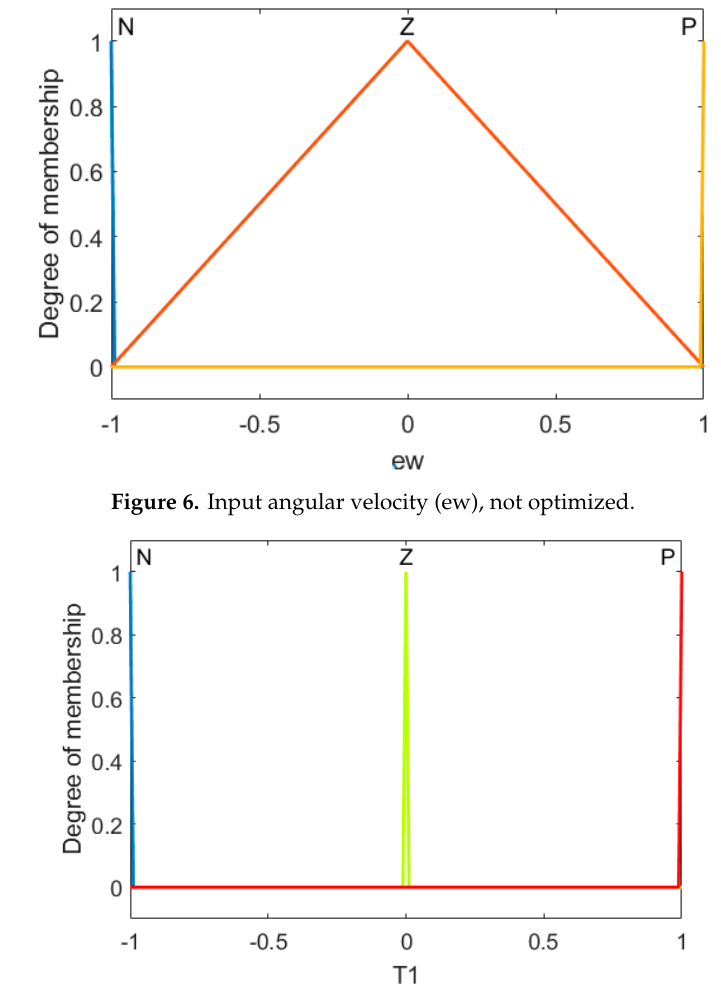
Figure 7. Output T1, not optimized. Figure 1. Output T1, not optimized. Figure 1. Output T1, not optimized.